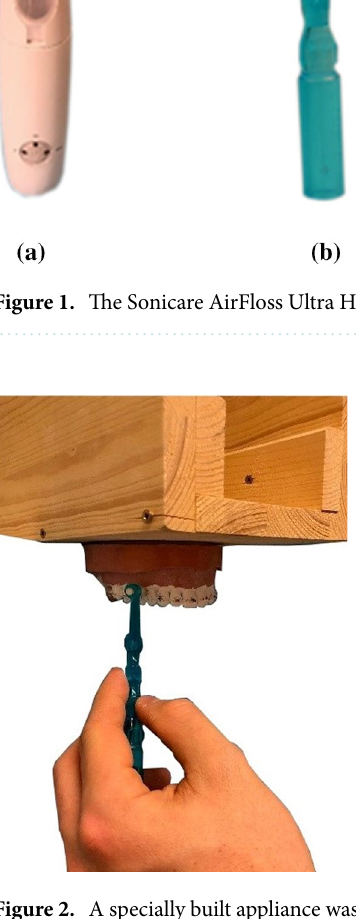
Figure 2. A specially built appliance was attached to the KaVo model to ensure standardized